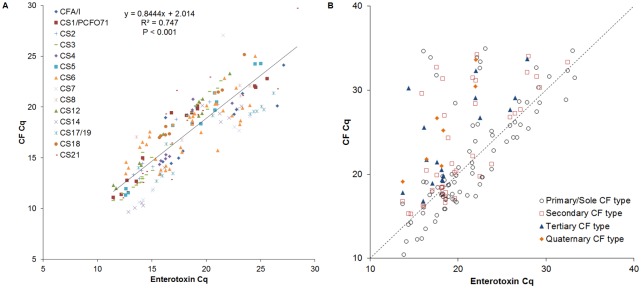
Correlation of Cqs between enterotoxin and CFs on cultures (A) and stool (B).(A) On culture (N = 194), the overall correlation R2 = 0.78 (P < 0.001). Each symbol represents one CF type. (B) On stool, the Cq correlation between enterotoxin and primary/sole CF (the most abundant CF type measured by Cq values), secondary CF (the second most abundant, if present), tertiary CF (the third most abundant, if present), and quaternary CF (the fourth abundant, if present) CF were all statistically significant (P < 0.05, with R2 = 0.66 (N = 81), 0.45 (N = 39), 0.46 (N = 17), and 0.82 (N = 7), respectively. The dotted line shows the diagonal line.